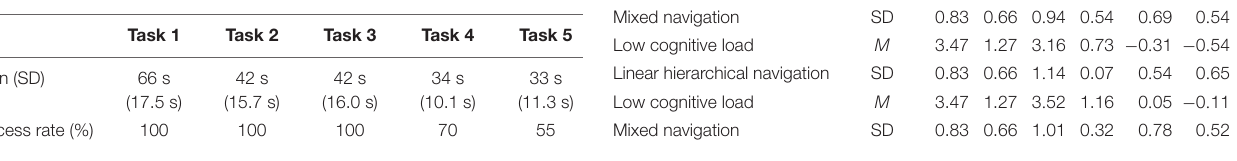
TABLE 2 | Mean value of completion time and success rate of each